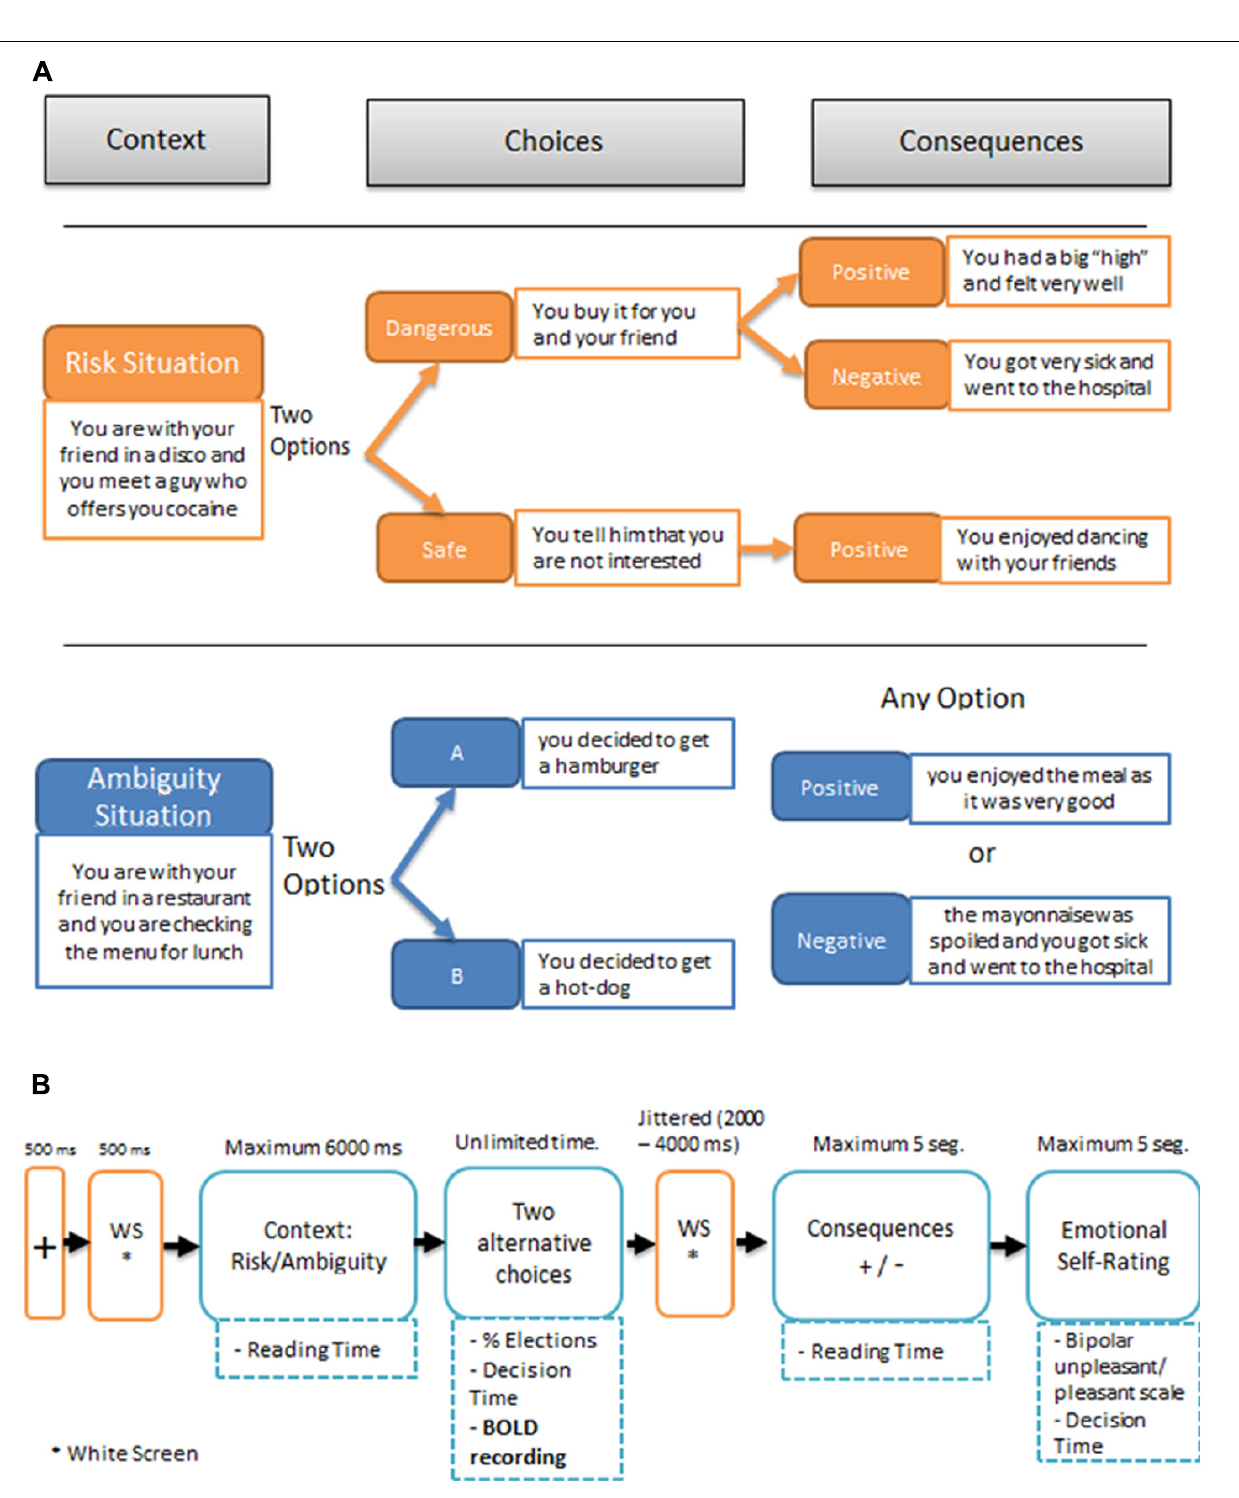
FIGURE 1 | (A) Examples of SCDT (Social Context DecisionTask), in risk and ambiguous scenarios. (B) Temporal sequence of events in a trial.